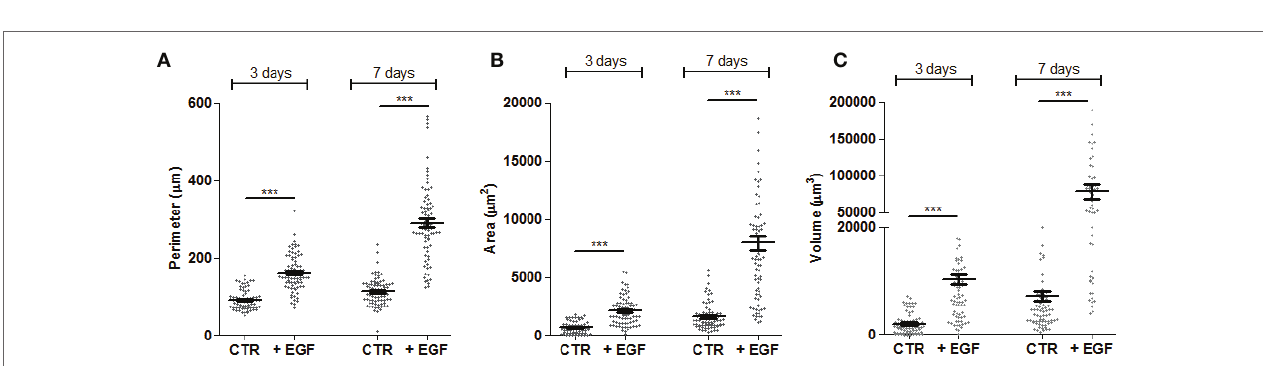
FIGURe 2 | Procedure of CRC spheroid image analysis and measurement. CRC spheroids (this example is referred to SW620 cell line) were analyzed under an inverted IX70 microscope (Olympus) with 10 × objective NA 0.30 (100 × magnification), equipped with an automated x – y axis motorized table SCAN IM (Marzhauser Wetzlar) and image taken under control of the CellSens computer program. (A) The entire well was reconstructed taking sequential and partially overlapping images, stitched one to each other to give rise to the image of the well. (B) Region of interest (ROI) that identify tumor cell spheroids and areas ( μ m 2 ) calculated by CellSens software after calibration of the image. (C) Data inserted by the CellSens software in an Excel sheet were analyzed with Graph Pad PRISM (version 5.03) software (d) . (d) Perimeters (upper graph) and areas (lower graph) of spheroids and single cells. Mean ± SEM of the ROI shown in panel (B) and measured in panel (C)